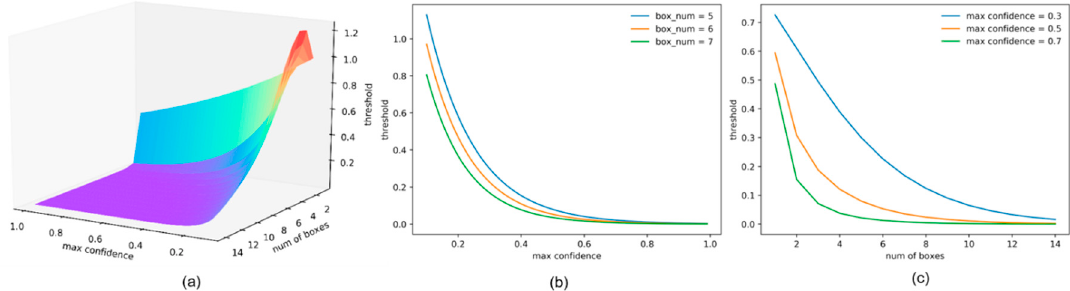
Figure 3. ( a ) Dynamic threshold distribution of the classification confidence and density of the detection boxes. ( b ) and ( c ) are the univariate relationships of the thresholds for the maximum classification confidence and the density of the detection boxes, respectively.